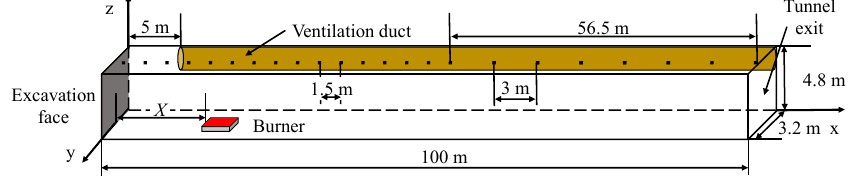
Figure 2. Schematic diagram of FDS model.